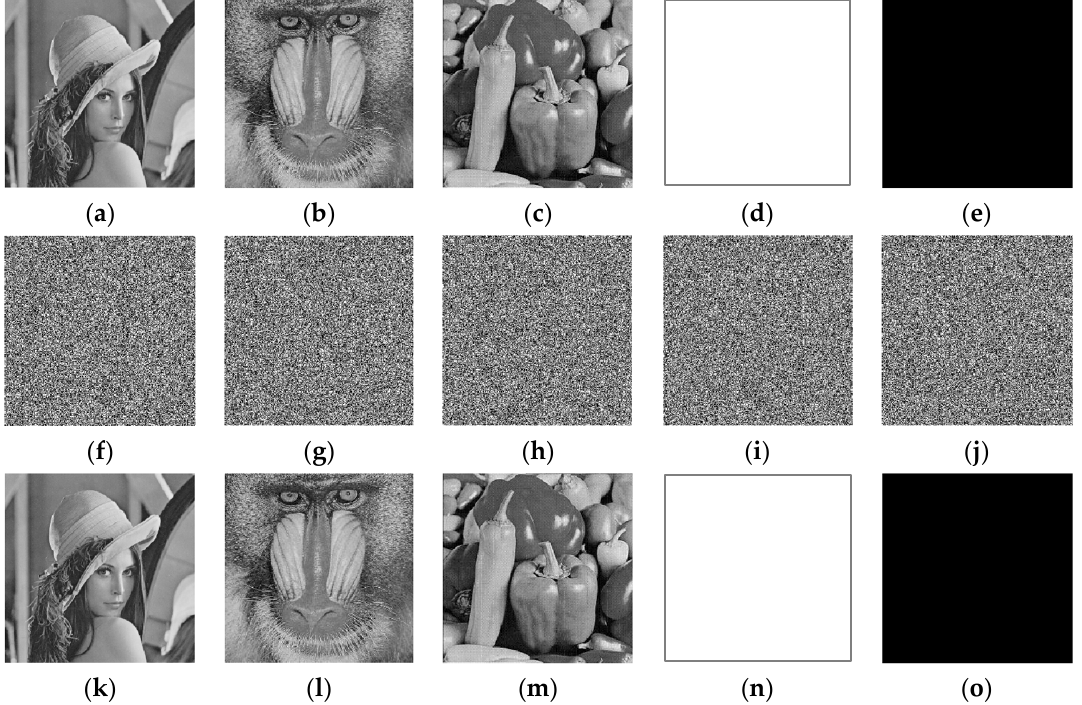
Figure 9. Simulation results (256 ∗ 256): ( a – e ) original images; ( f – j ) encrypted images; ( k – o ) decrypted images.